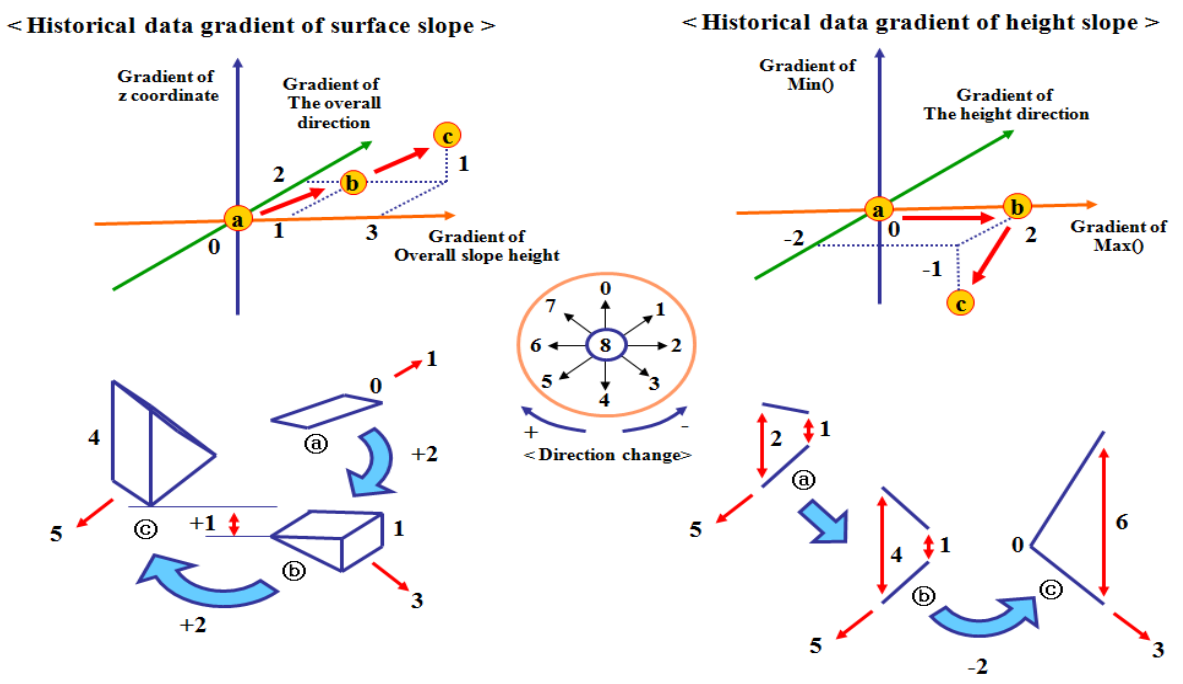
Figure 6. The historical gradient coordinate and data trend